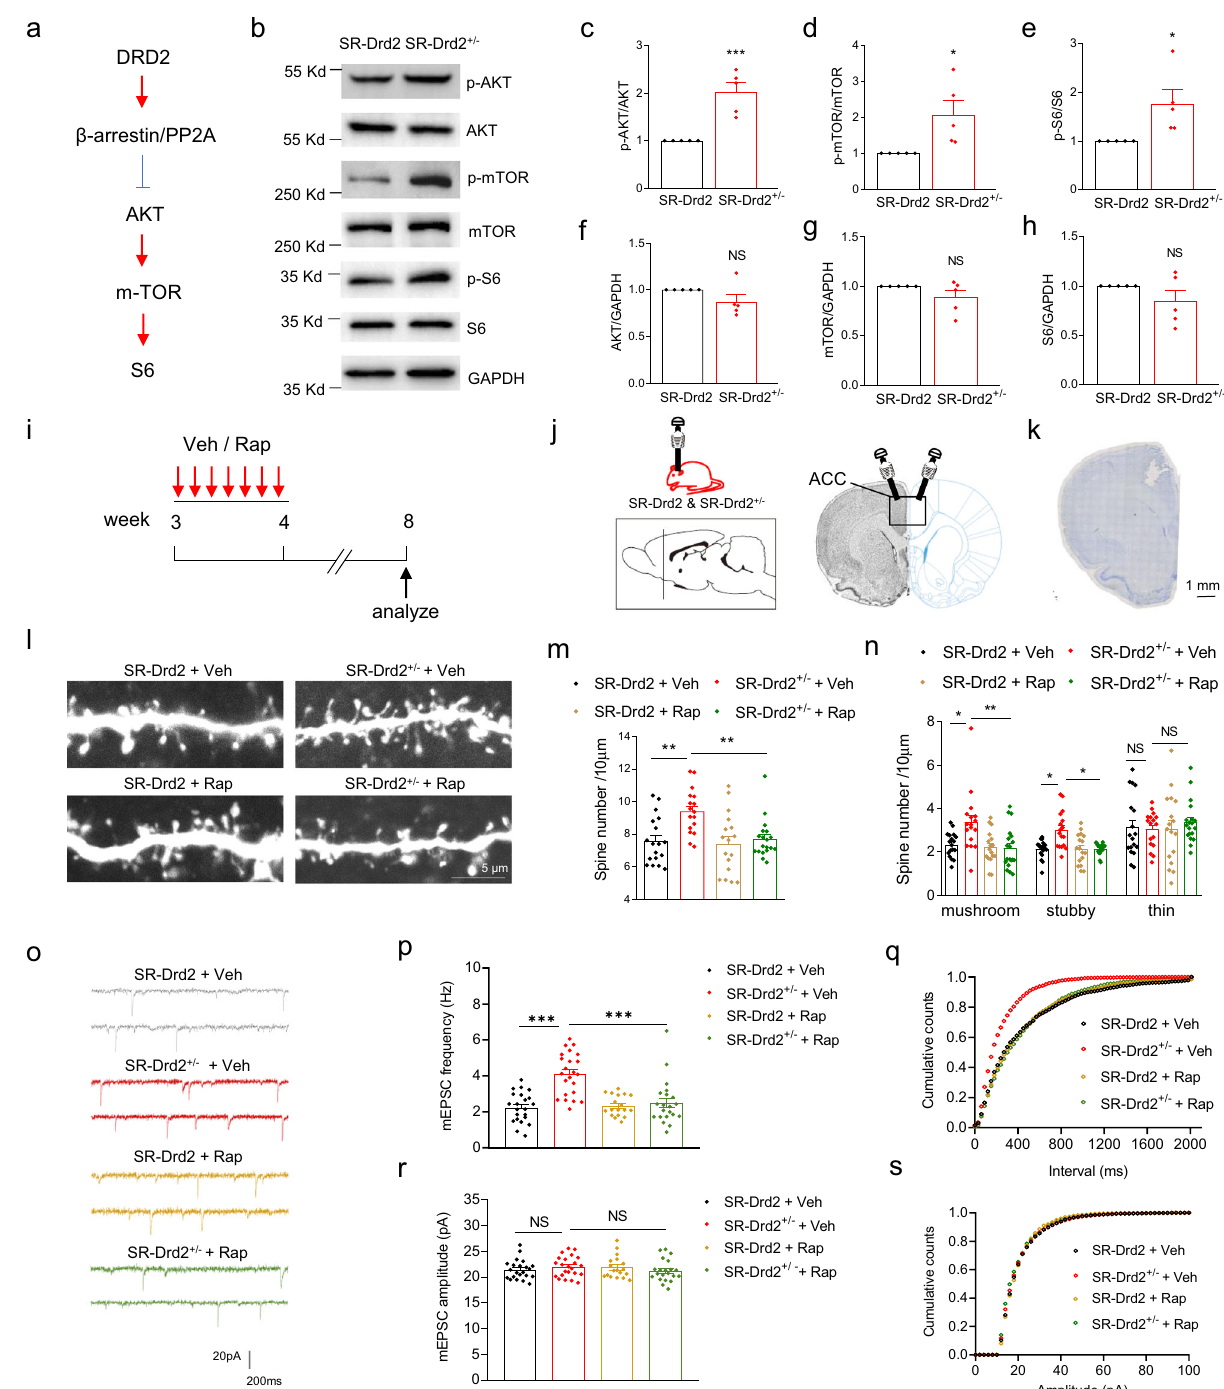
in Drd2-positve but not Drd2-negative neurons (Fig. 6d, e). To study whether Drd2 heterozygous mutation affected dendritic spines in Drd2-negative neurons, we fi lled the Drd2- negative neurons with biocytin and used immuno fl uorescence to reveal the dendritic spines (Fig. 6f, g). We analyzed the spines from the secondary basal dendrites of Drd2-negative neurons as we did for Drd2-positive neurons. As contrary to the increased spine density in Drd2-positive neurons (Fig. 2f – i), the